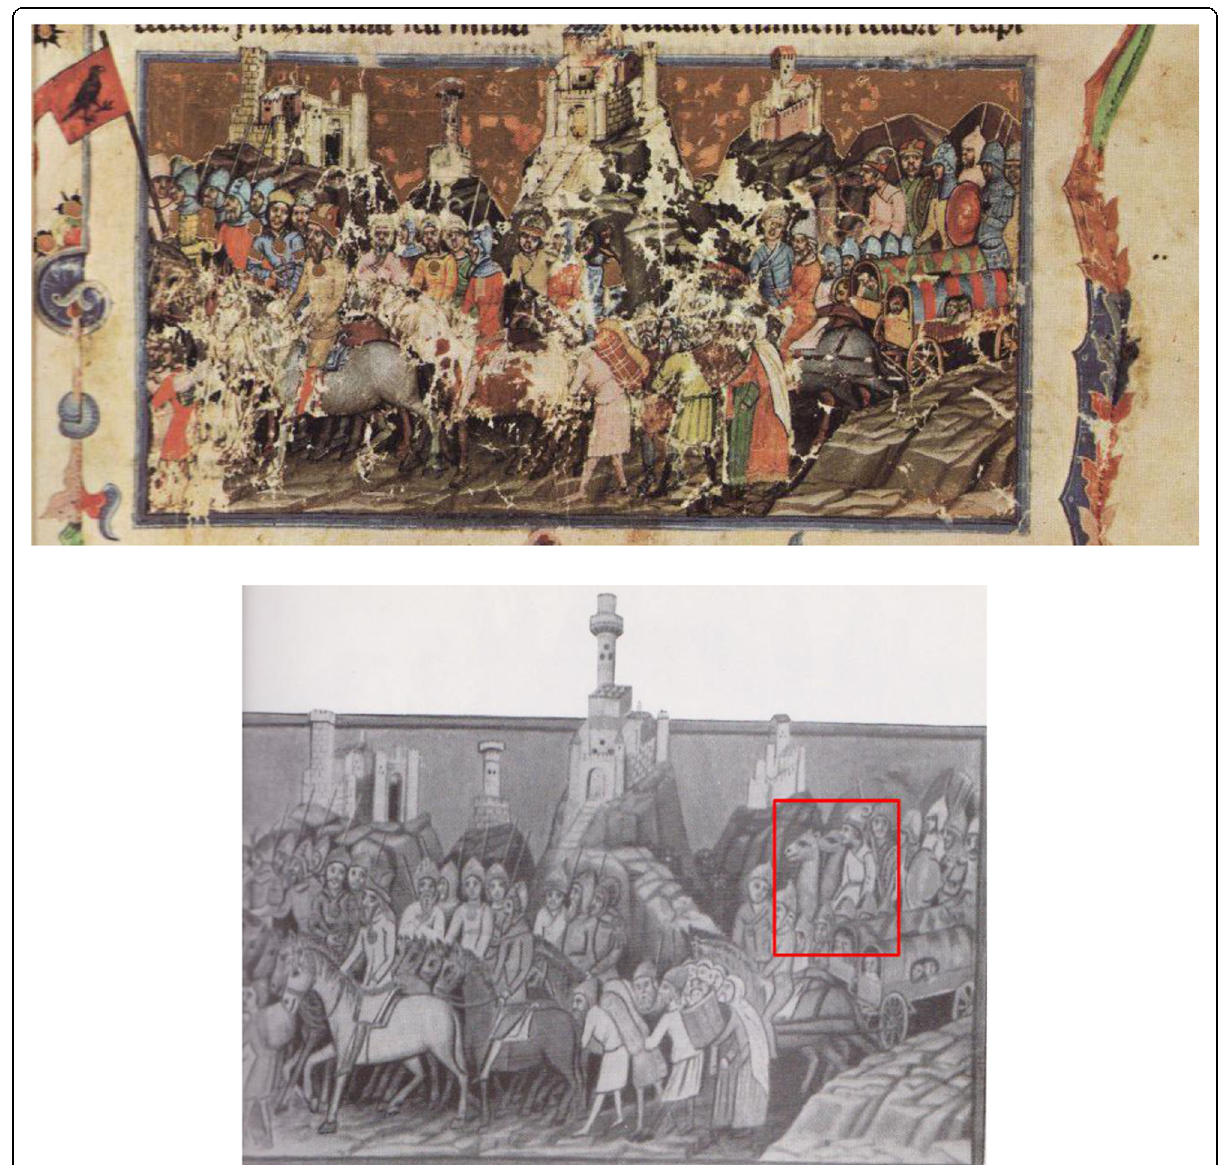
Fig. 2 Immigration of Huns to Pannonia — Primus ingressus Hungarorum in Pannoniam (National Szechenyi